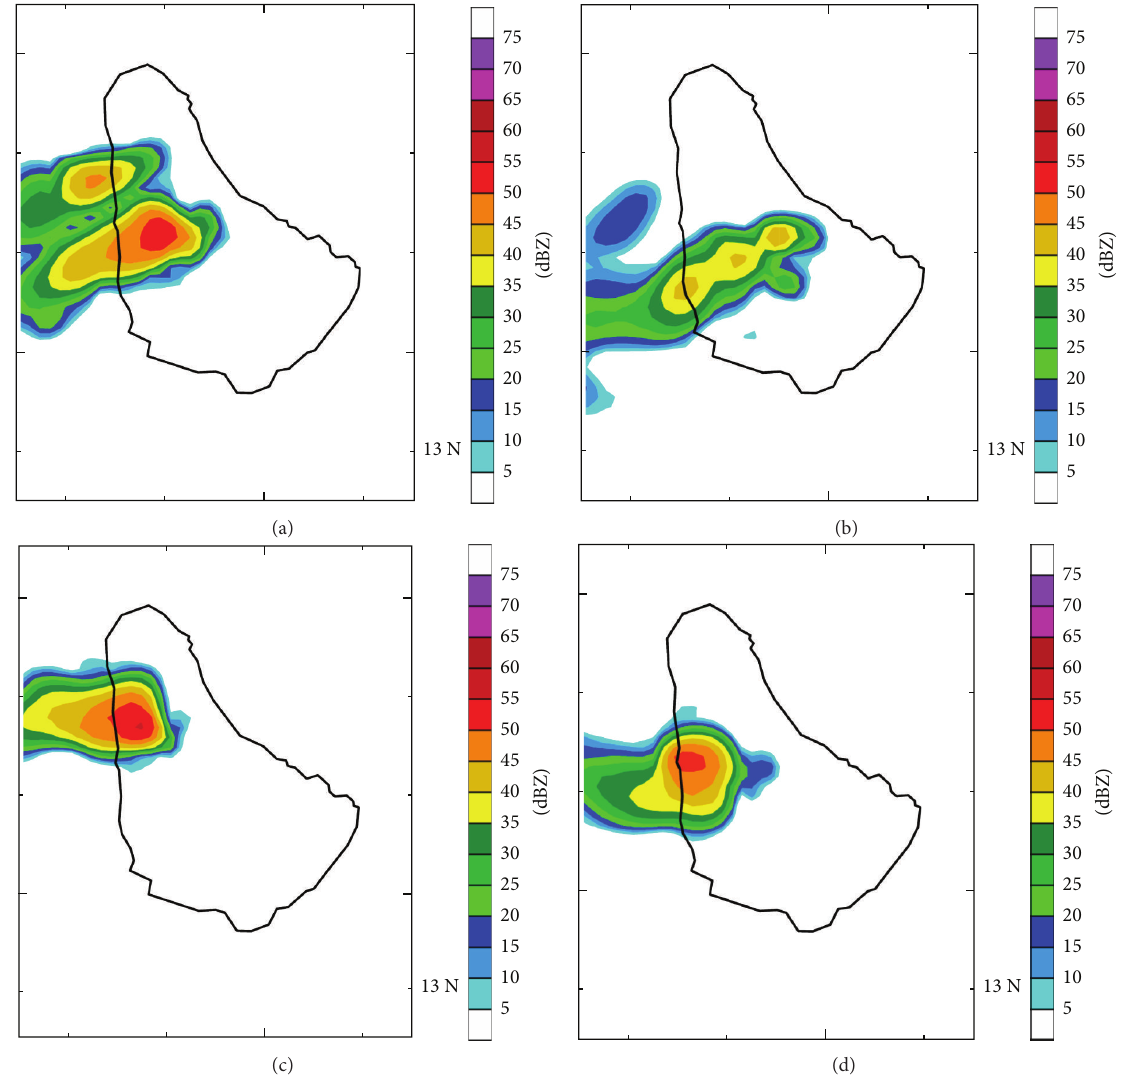
Figure 5: Simulated radar reflectivity for the CTRL experiment valid at (a) 1430UTC and (b) 1500UTC; (c) and (d) are at the same time as (a) and (b) but for